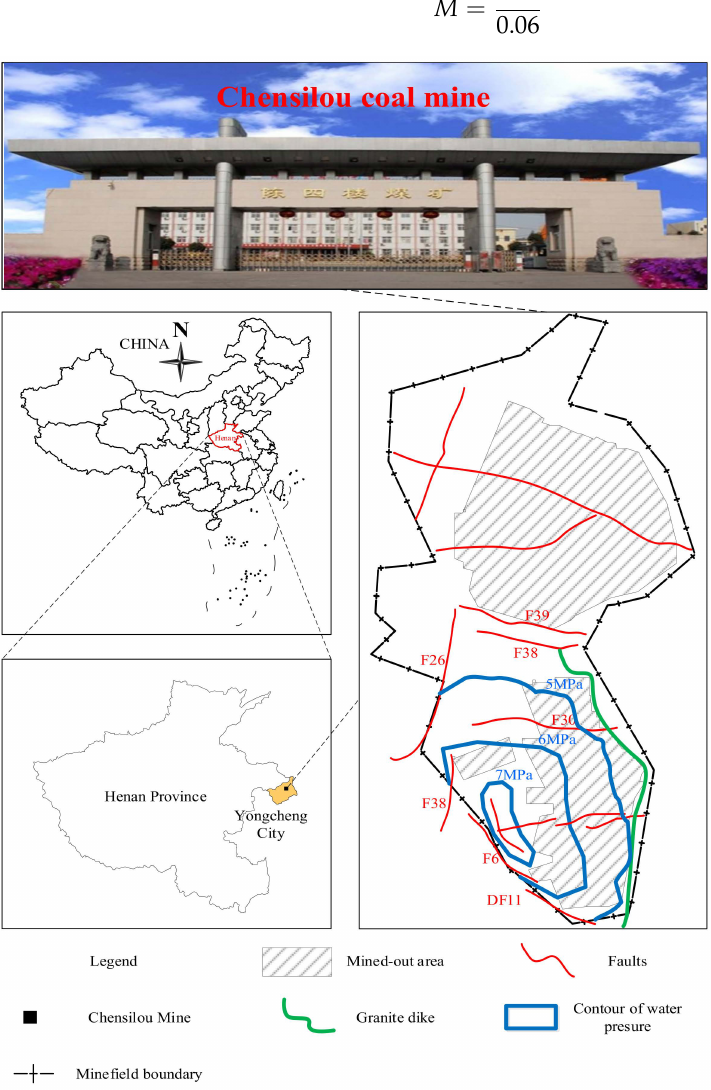
Figure 4. Location of the study